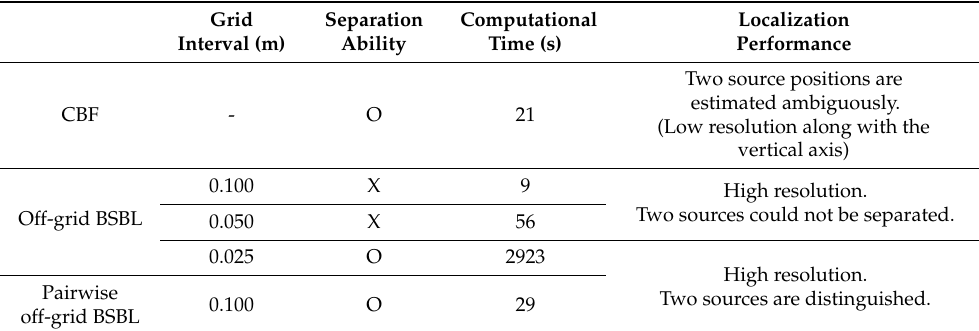
Table 1. Localization results of adjacent noise sources along with various schemes.